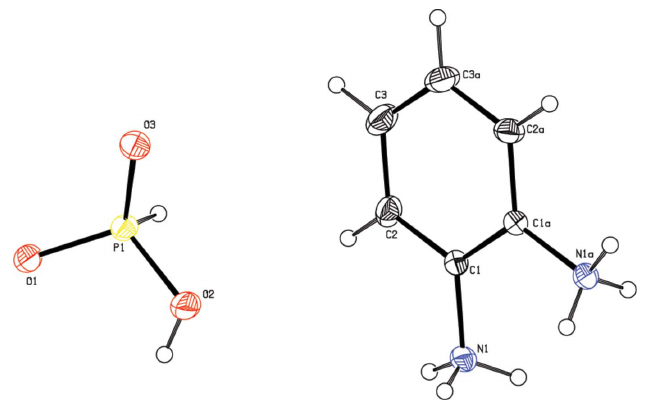
Figure 1 The molecular structure of the title molecular salt, with atom labelling and 30% probability displacement ellipsoids. [Symmetry code: ( a ) 1 (cid:3) x , (cid:3) z y , 3 2